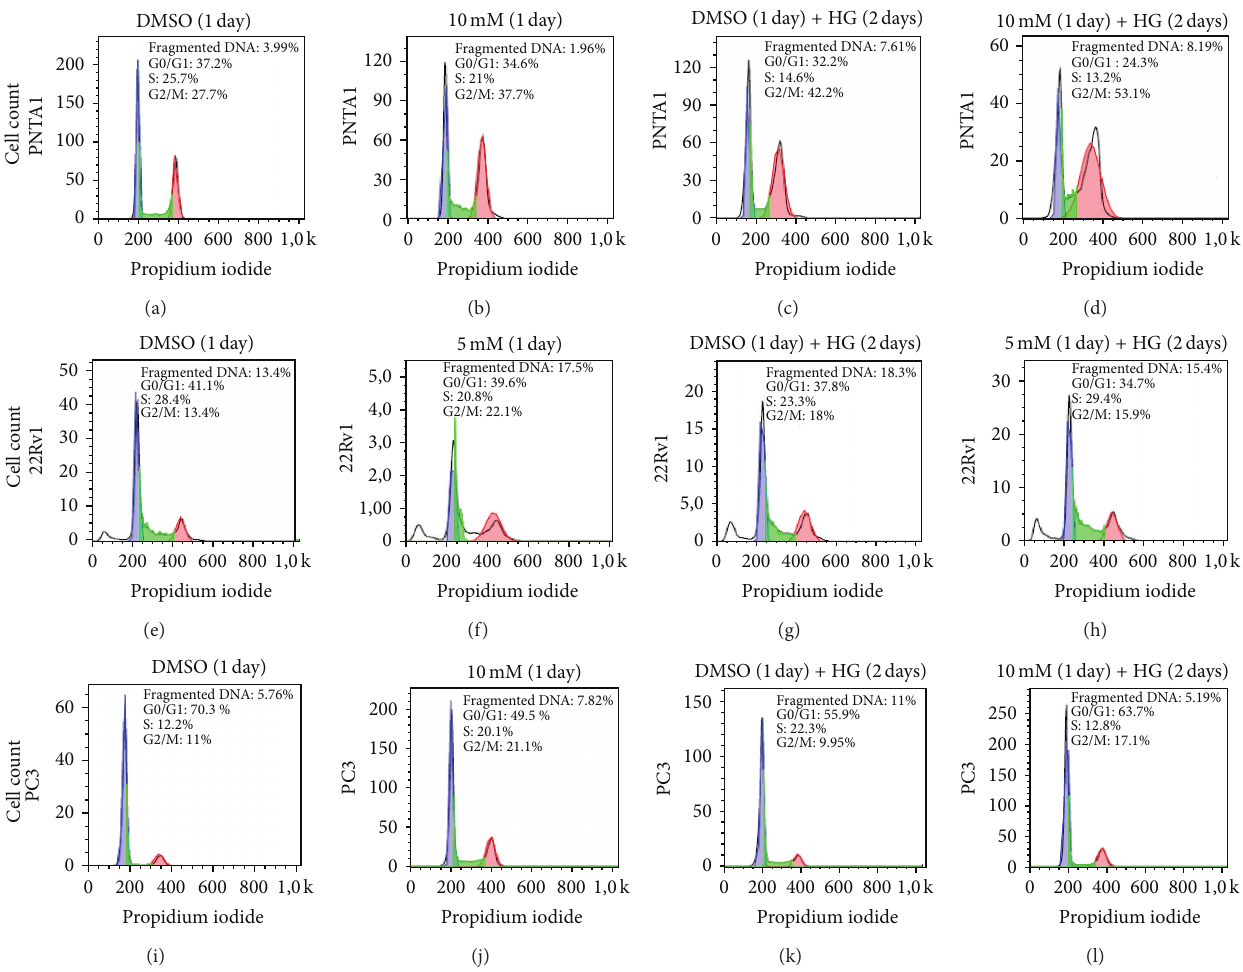
Figure 7: Determination of cell cycle analysis by DNA content using flow cytometry. 22Rv1 ((a), (b), (c), and (d)), PNTA1 ((e), (f), (g), and (h)), and PC3 ((i), (j), (k), and (l)) cells maintained under normal conditions ((a), (e), and (i)), treated with MLT (5mM or 10 mM) for 1 day ((b), (f), and (j)), incubated with HG medium for 2 days ((c), (g), and (k)), and preincubated with HG medium for 1 day and then exposed to MLT (5 mM or 10mM) for an additional 1 day ((d), (h), and (l)). DNA fragmentation: white peaks; G0/G1: blue peaks; S: green areas; and G2/M: red